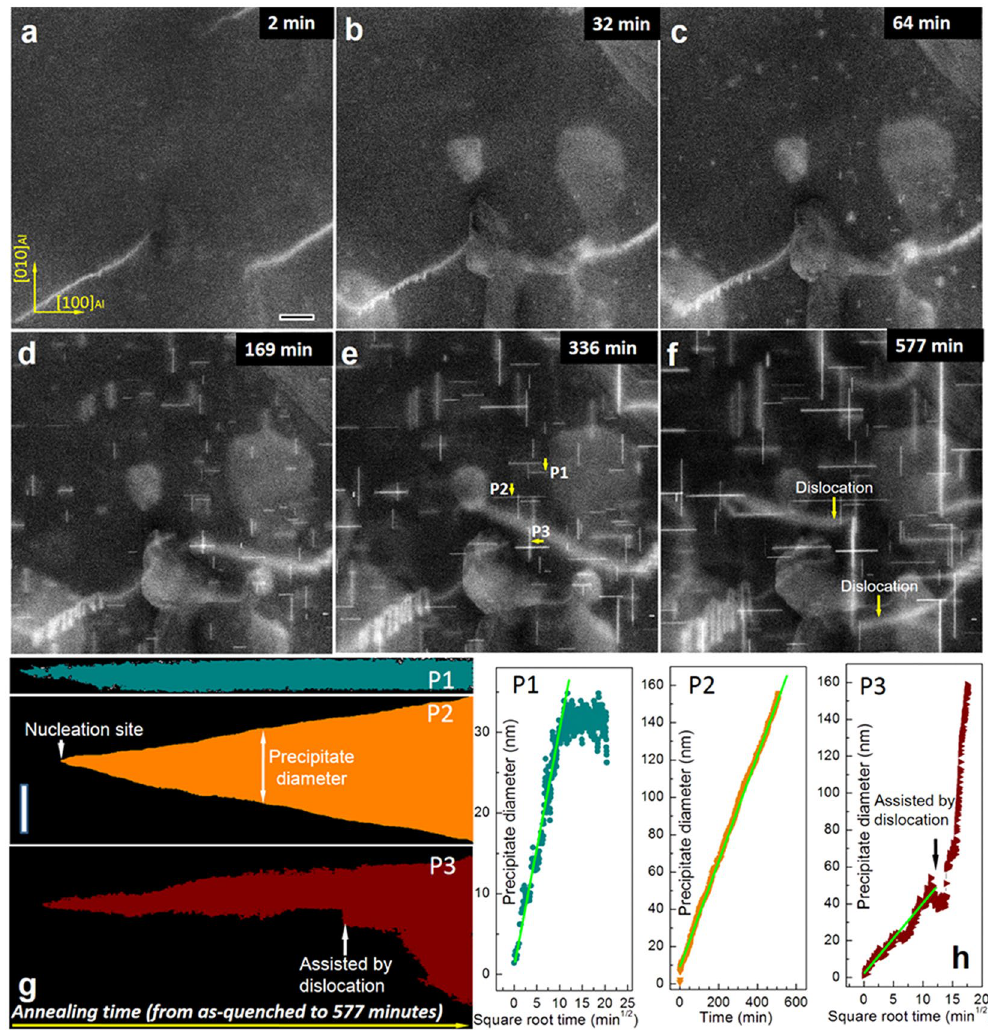
Figure 1. Real-time observation of the growth of precipitates in Al-Cu alloy. ( a – f ) Snapshots from an in-situ ADF-STEM Movie S2 showing the growth of plate-like precipitates in the Al-Cu alloy during ageing at 160 °C, with the electron beam parallel along the 〈 001 〉 Al direction. The small sub 5 nm bright spots increasing in contrast in ( a , b , c ) are small precipitates growing into the larger precipitates visible as lines in ( d , e , f ). The larger (up to 150 nm diameter) bright areas are copper enriched precipitates formed at the foil surface. ( g ) Average length diameter of seven precipitates monitored from the moment of nucleation. ( h ) The growth trajectories of the precipitates P1, P2 and P3, formed at various stages of ageing. The horizontal scale bar in ( a ) is 50 nm and refers to all figures ( a – f ). The vertical scale bar in ( g ) is 50